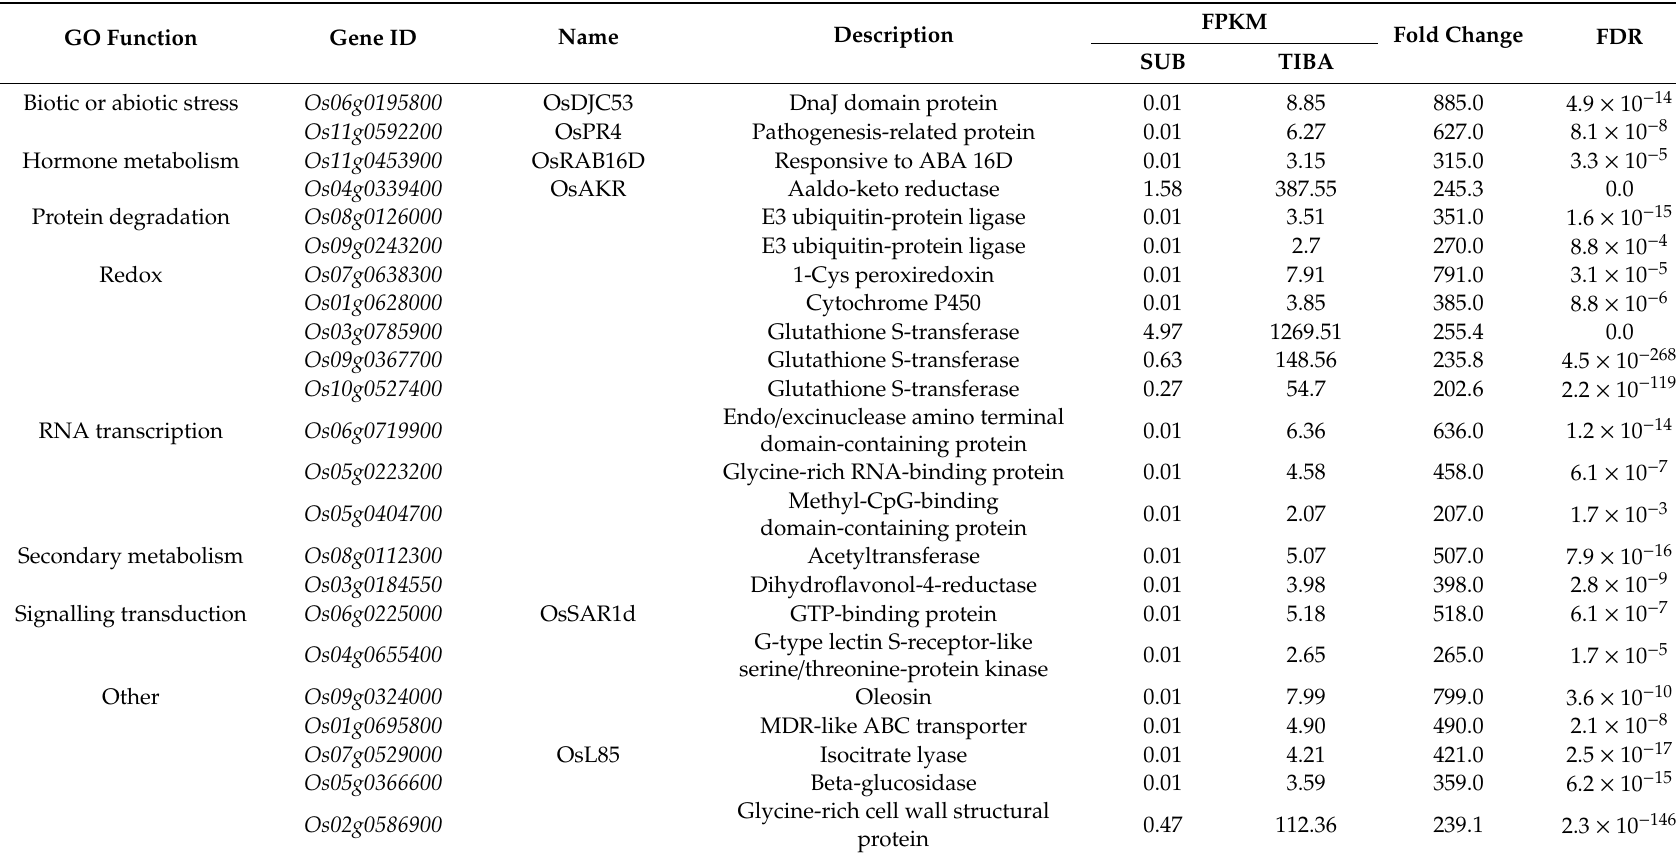
Table 1. The di ff erentially expressed gene was significantly upregulation between submergence (SUB) and submergence with 10 µ M TIBA (SUB + TIBA) in